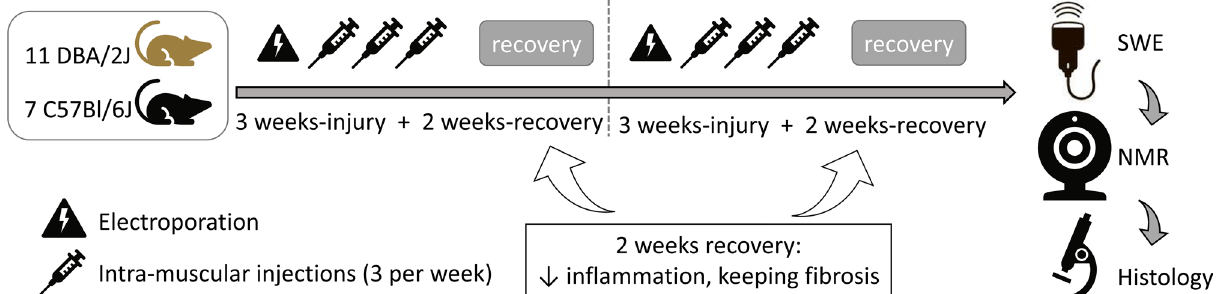
Figure 1. Experimental design: fibrosis induction in wild-type mice. Extensive (electroporation) and localized injuries (intramuscular injections in the left tibialis cranialis (TC)) were combined on the first day of the two injury cycles. Localized injuries were then repeated three times per week during 3 weeks. A 2-week interval at the end of each injury cycle allowed the reduction of muscle inflammation, while fibrosis was still present. The injury cycle took place twice. Only the left leg was injured, and muscles in the right leg served as controls for each mouse in paired comparisons. After 10 weeks of injury/recovery, nuclear magnetic resonance (NMR) and shear-wave elastography (SWE) were performed in vivo. Muscles were then collected after euthanasia for histological analysis. DBA/2J and C57Bl/6 were included in this study to induce variable levels of skeletal